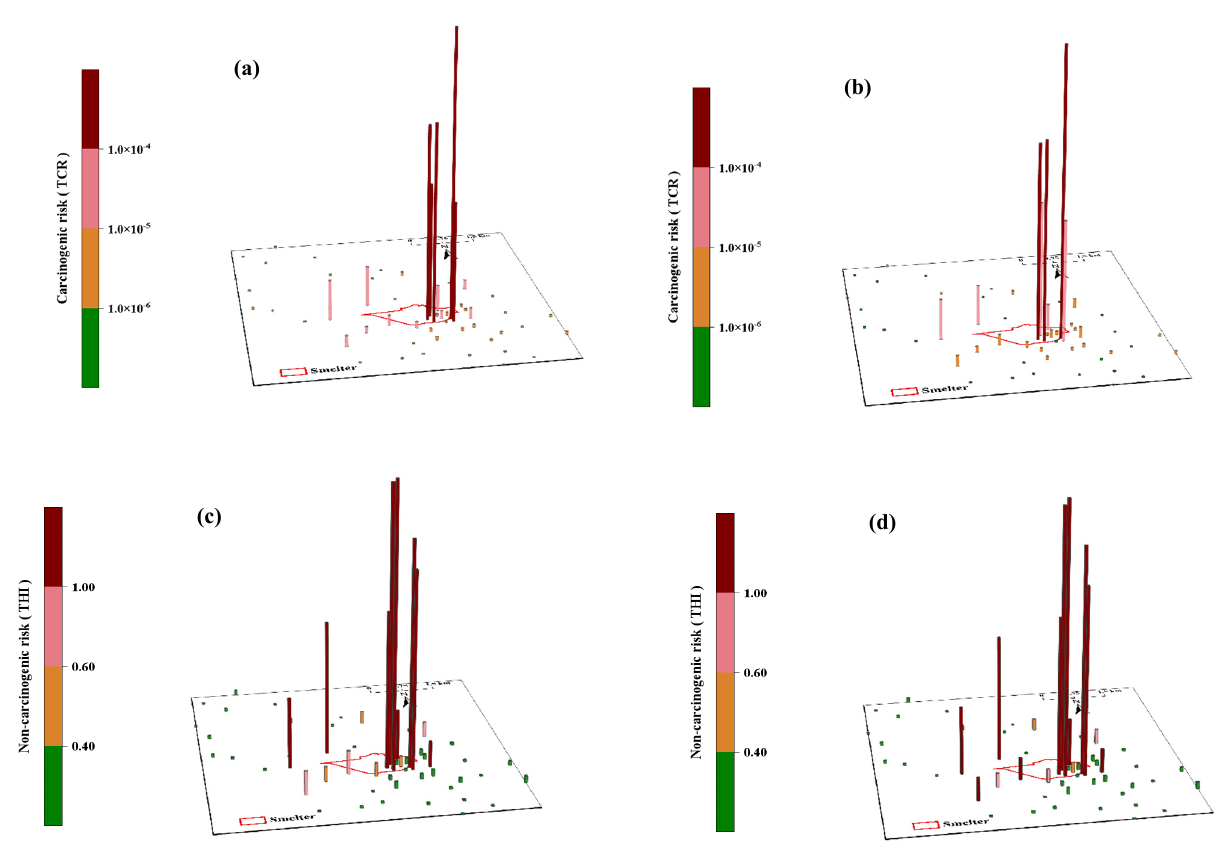
Figure 5. Health risk assessment for sampling sites of surrounding areas and non-ferrous metal smelting plant (NMSP): ( a ) cancer risk for adults, ( b ) cancer risk for children, ( c ) non-cancer risk for adults, and ( d ) non-cancer risk for children.